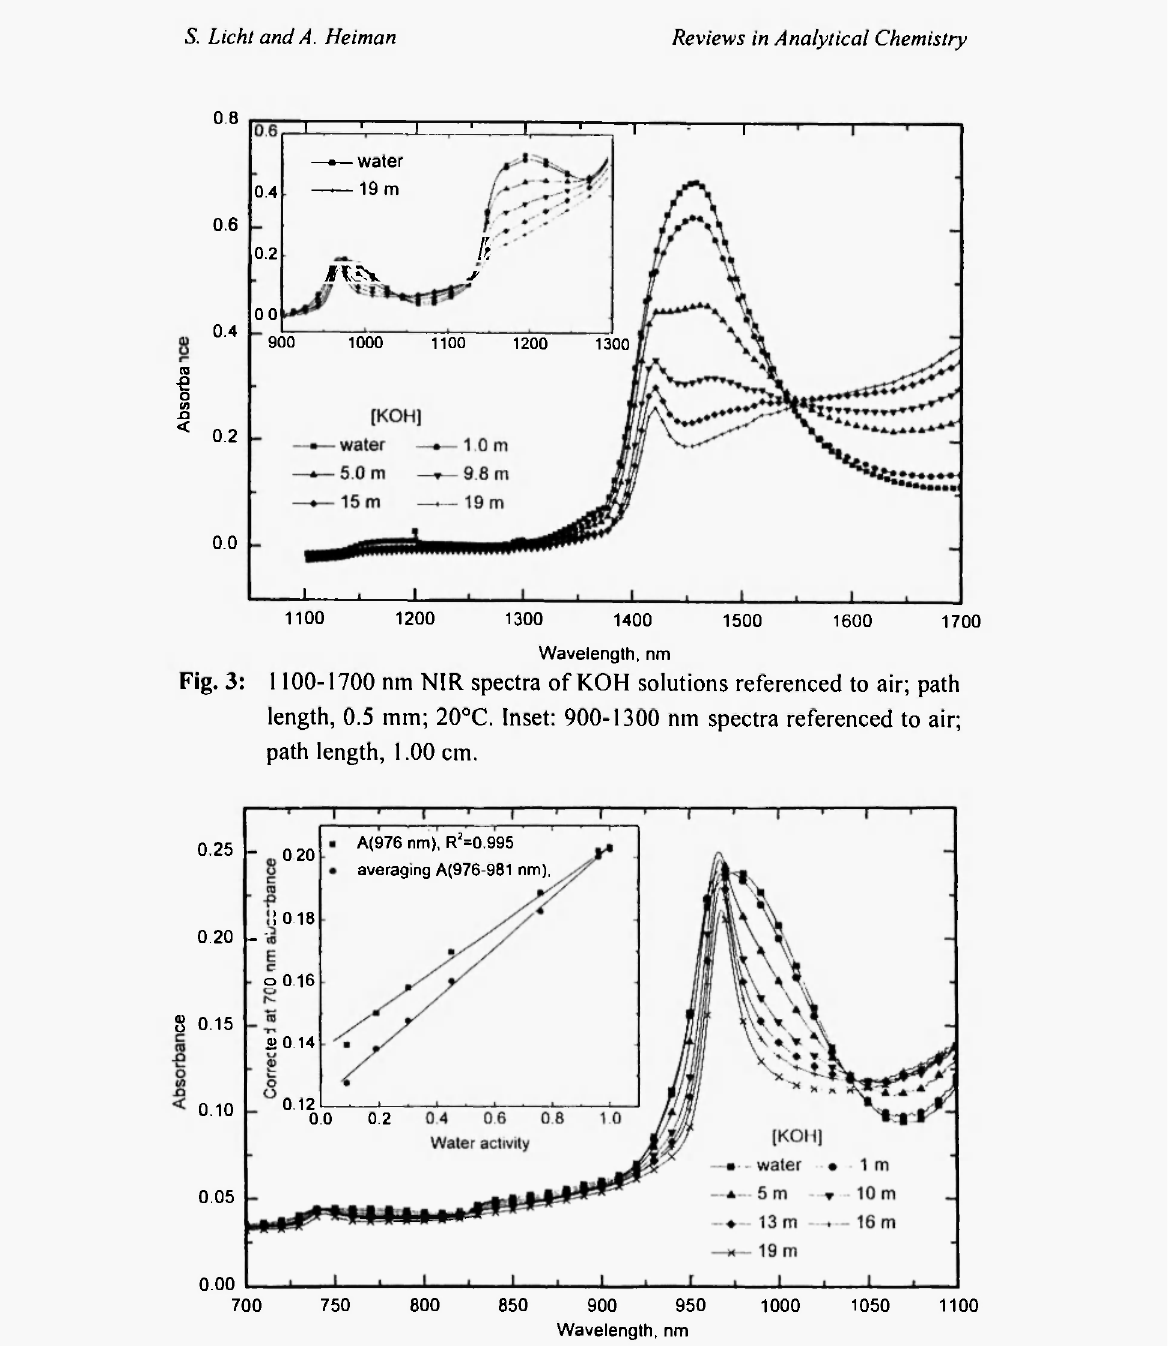
Fig. 4: Short-wave NIR spectra of KOH solutions referenced to air; path length, 1.00 cm; 20°C. Inset: absorbance of KOH solutions corrected at 700 nm on water